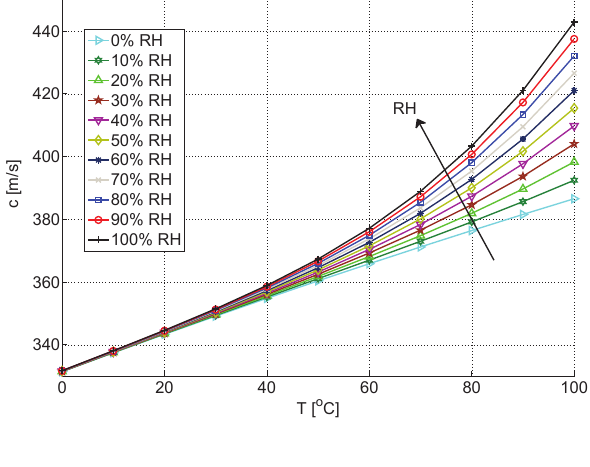
Figure 1. Speed of sound vs. temperature and relative humidity according to [2], p = 101 . 3 kP a , 314 ppm CO 2